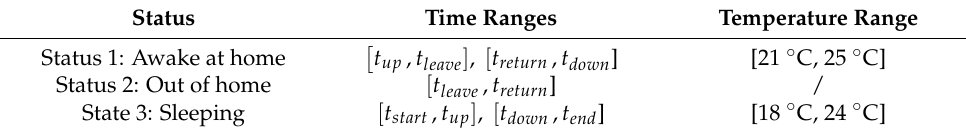
Table 2. User status division.